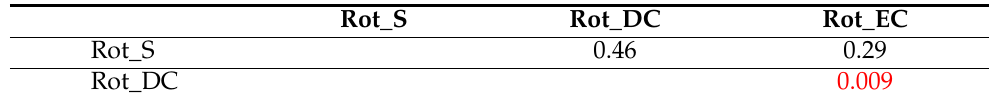
Table A2. Pairwise Wilcoxon rank sum test results for No_error. The number is marked red when it is statistically significant ( p < 0.05)